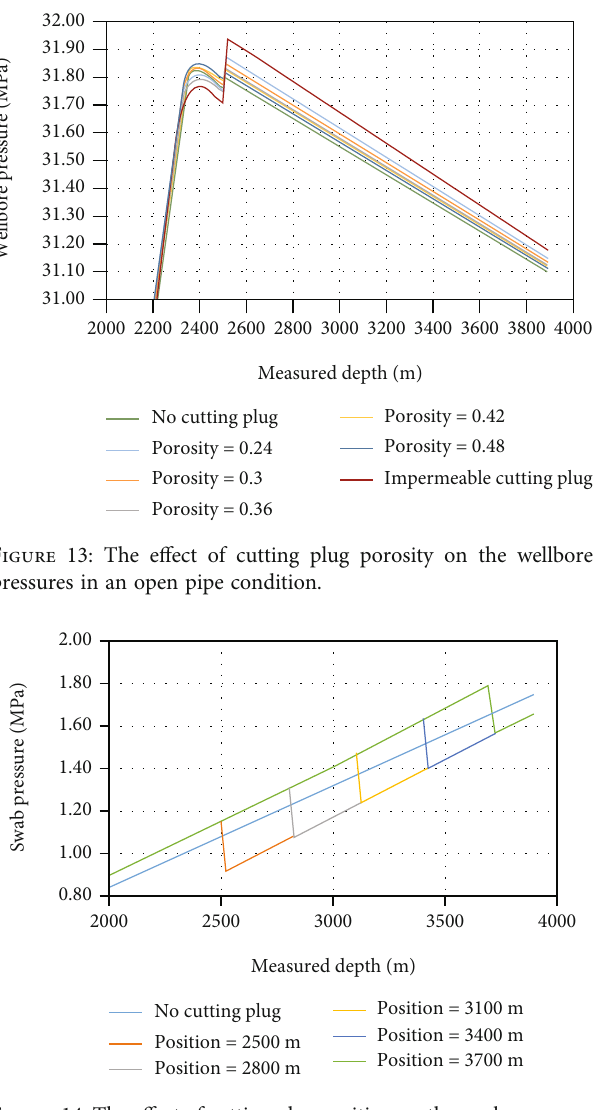
Figure 12: The e ff ect of cutting plug length on the wellbore pressures in an open pipe condition.